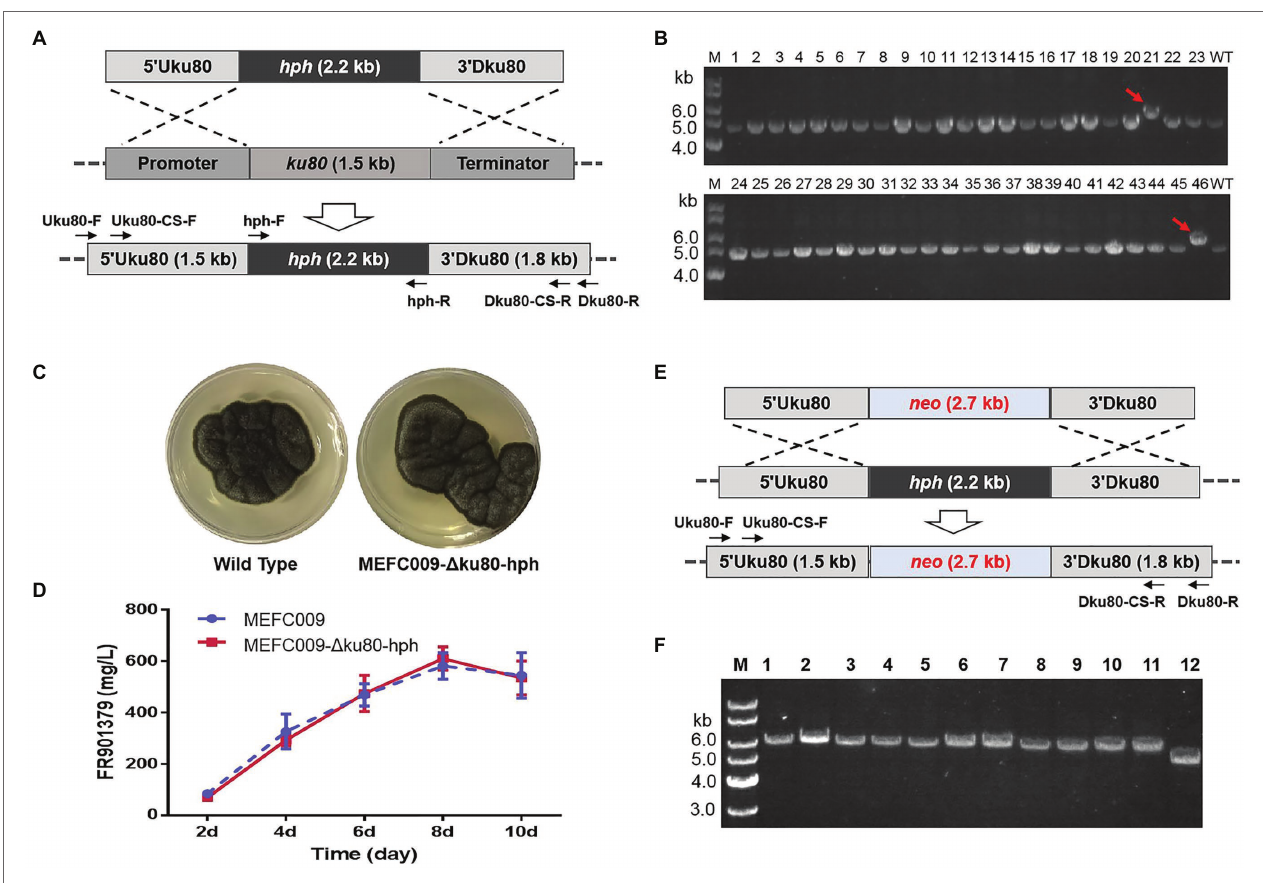
FIGURE 5 | Construction of the chassis cell with high gene-targeting frequency. (A) Strategy for deleting ku80 gene in C. empetri MEFC009. (B) Genotype verification of transformants using primers Uku80-F/Dku80-R. Lane M: 1 kb DNA marker; lane 1–46: transformants; lane WT: C. empetri MEFC009. The gene- targeting cassette was integrated at ku80 loci only in transformants NO.21 and NO.46. (C) Comparison of cell growth on PDA plates. (D) Comparison of the FR901379 production. (E) Strategy for replacing the hph marker in C. empetri MEFC009- Δ ku80-hph with neo . (F) Genotype verification of C. empetri MEFC009- Δ ku80-neo. Lane M: 1 kb DNA marker; lane 1–11: transformants; lane 12: parent strain C. empetri MEFC009- Δ